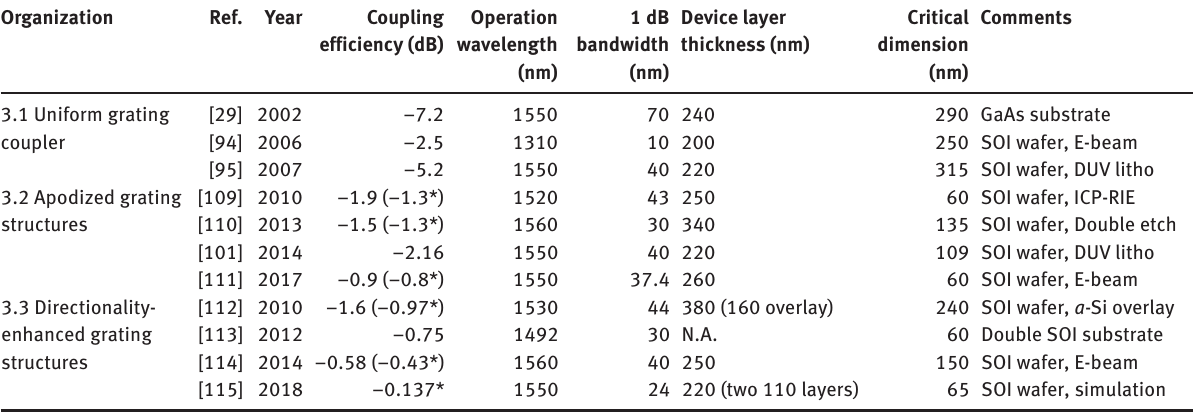
Table 2: Summary of the reported diffraction grating-based optical coupling.